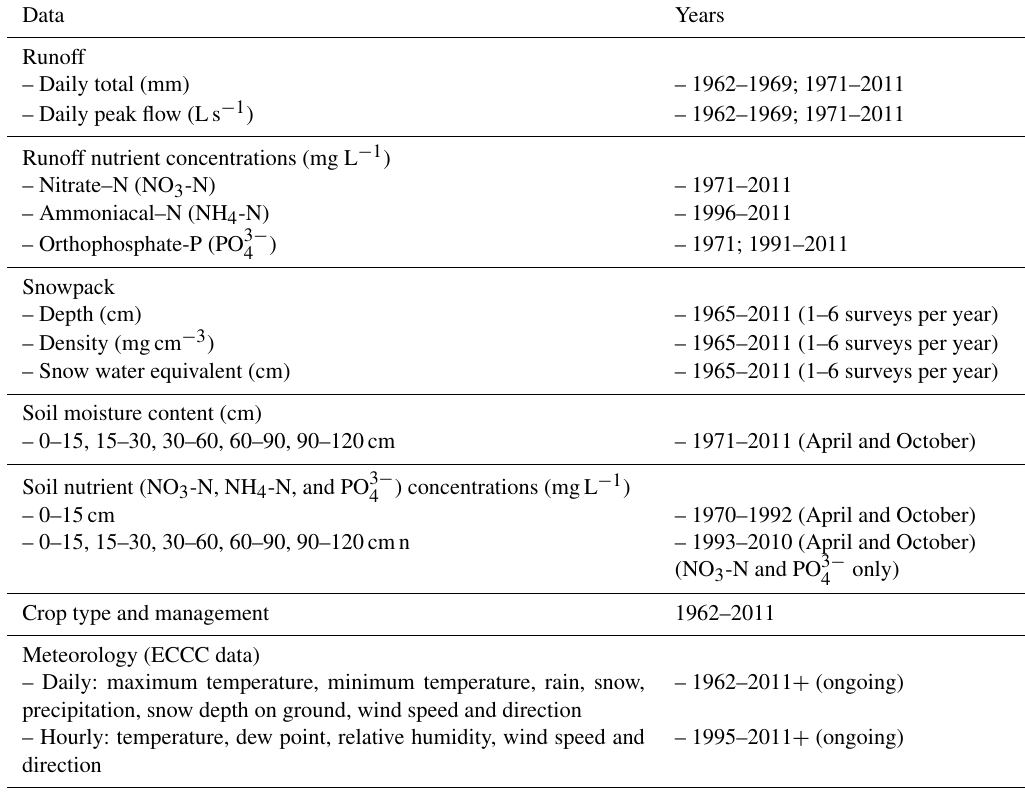
Table 2. Summary of data available and years recorded.